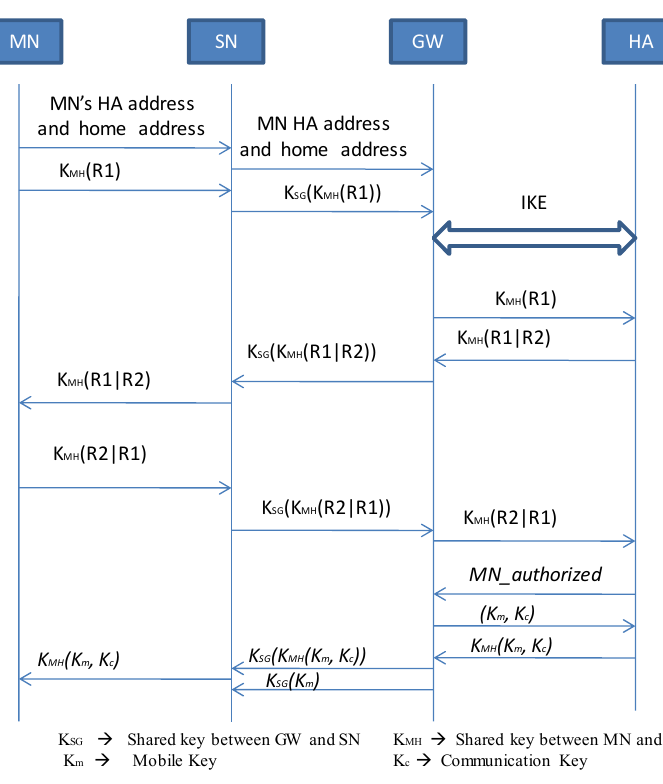
Figure 14. Authentication of a new